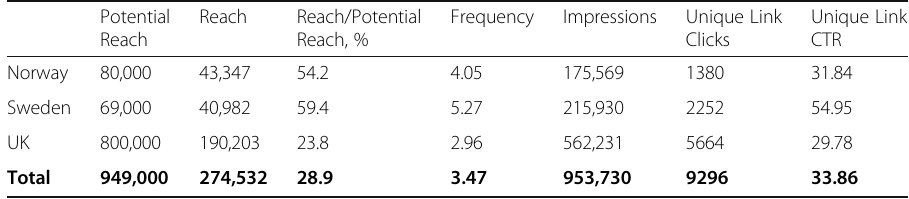
Table 2 Effectiveness indicators a of the Facebook advertisement campaign by